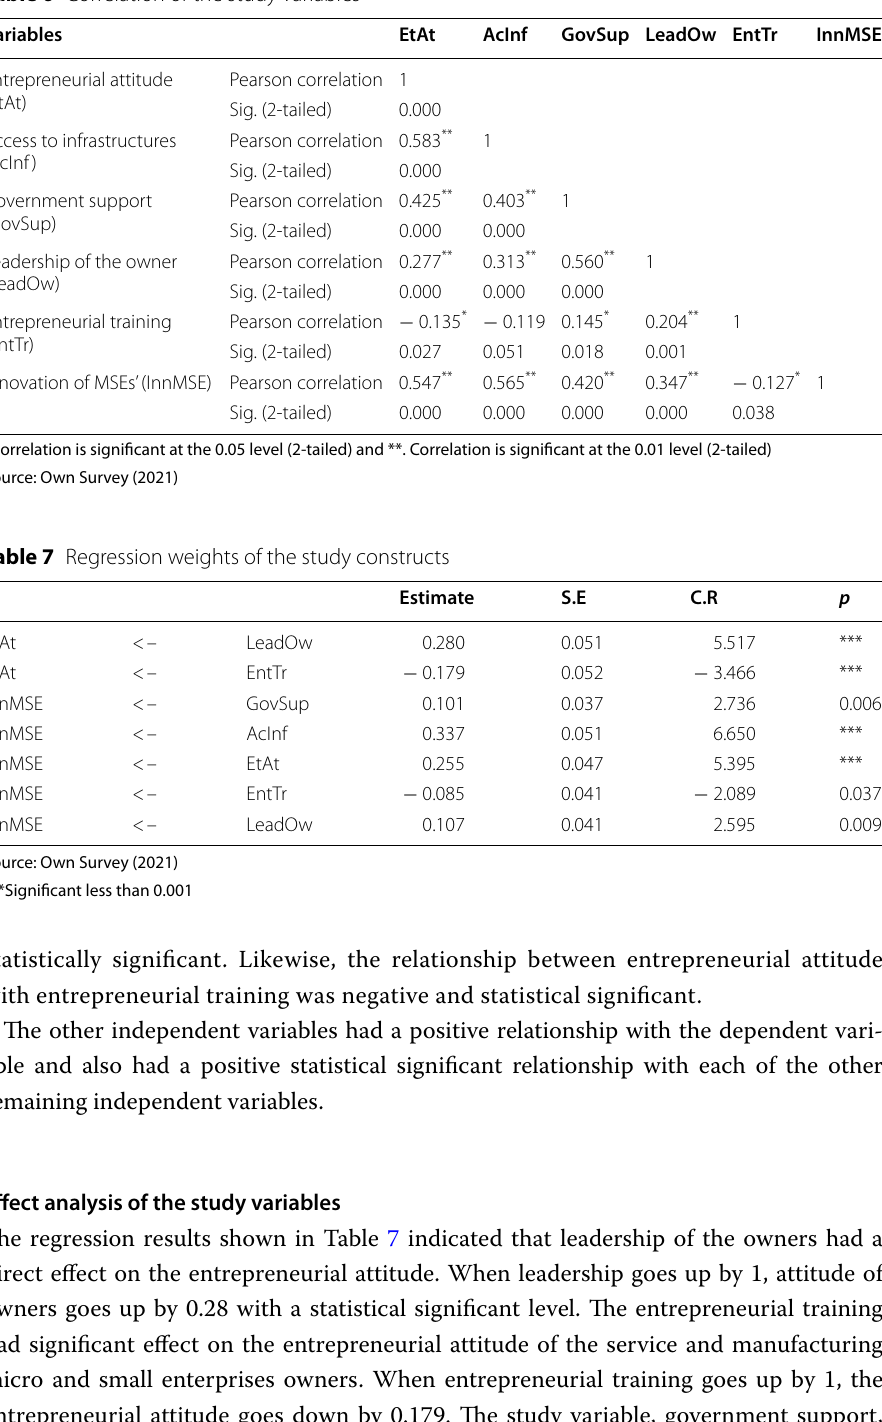
Table 6 Correlation of the study variables